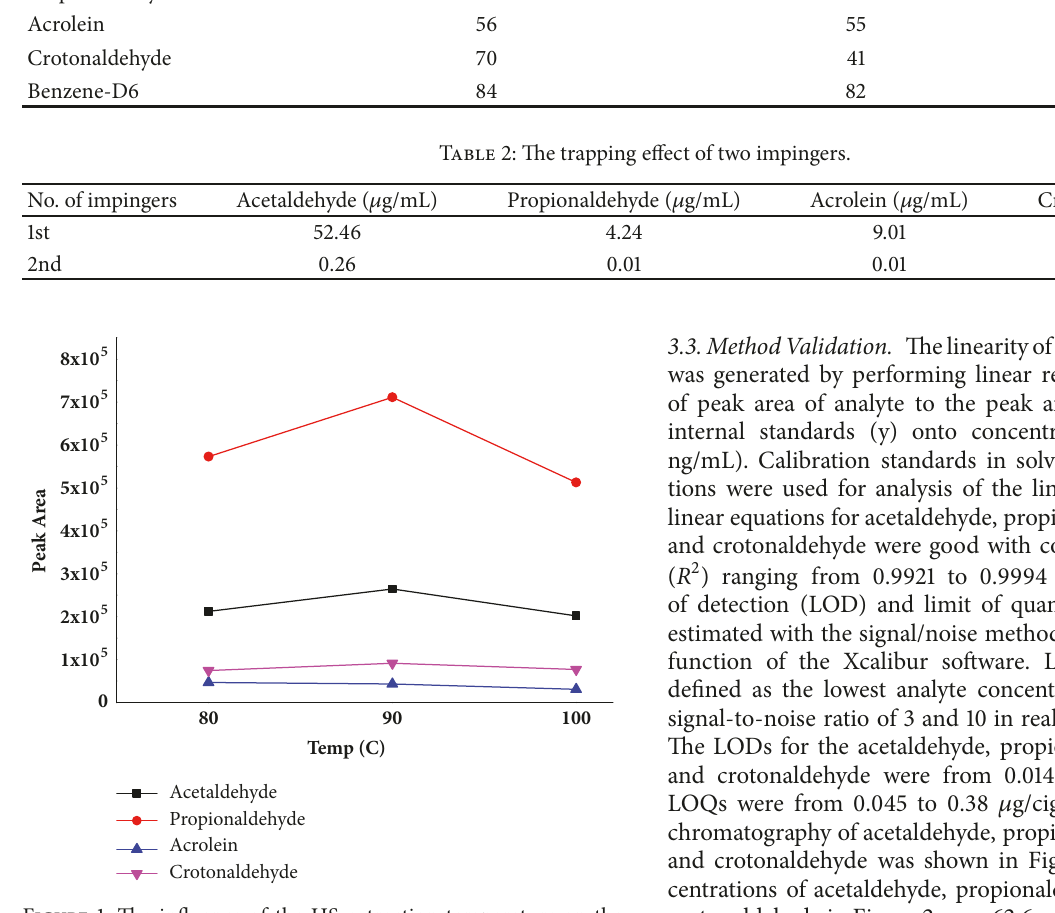
Figure 1: The influence of the HS extraction temperature on the peak area of each